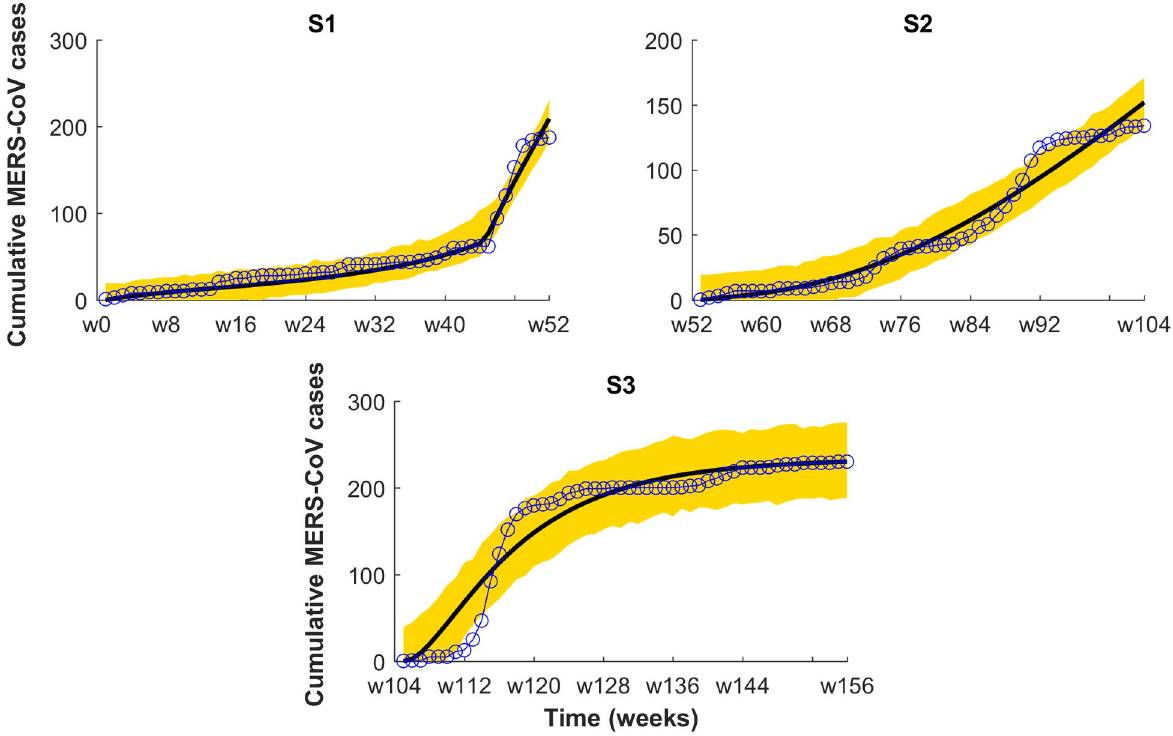
Fig 8. Season-wise model fitting to cumulative cases of Riyadh from July 6, 2013 to June 28, 2016. (Model fitted is a 2-strain model with saturated incidence. One year appears in each panel S1 to S3(S1 = S2 = S3 = 52 weeks). Line and circle line refers to observations and 95% confidence interval for cumulative predictions denoted by the yellow